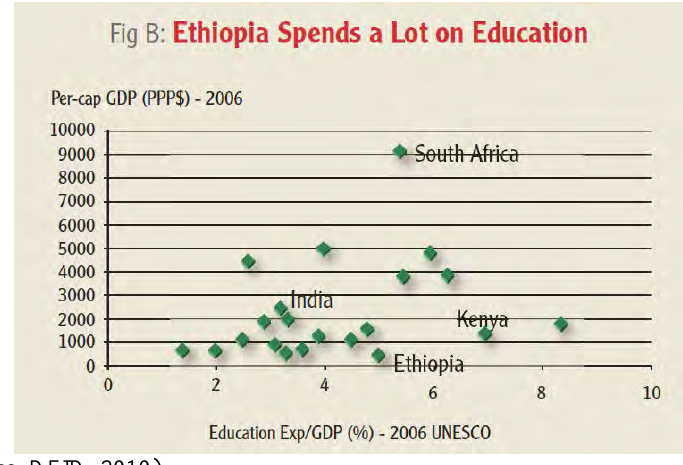
Figure 5-1: Education Expenditure Percentage of GDP, 2006